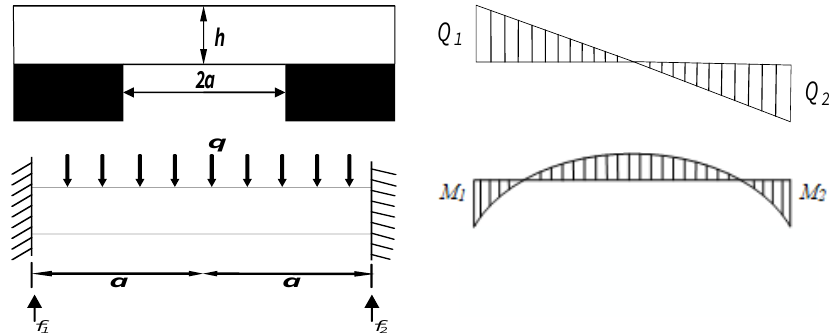
Figure 5. ‘Beam’ bending model before roof collapse.